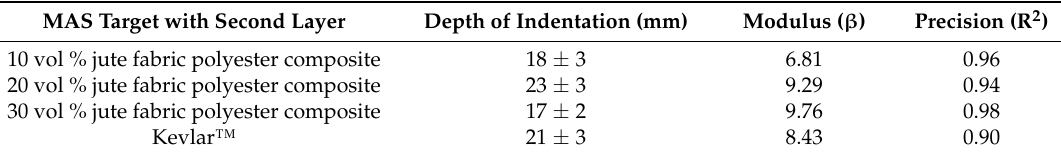
Table 1. Depth of indentation for different investigated multilayered armor systems. MAS Target with Second Layer